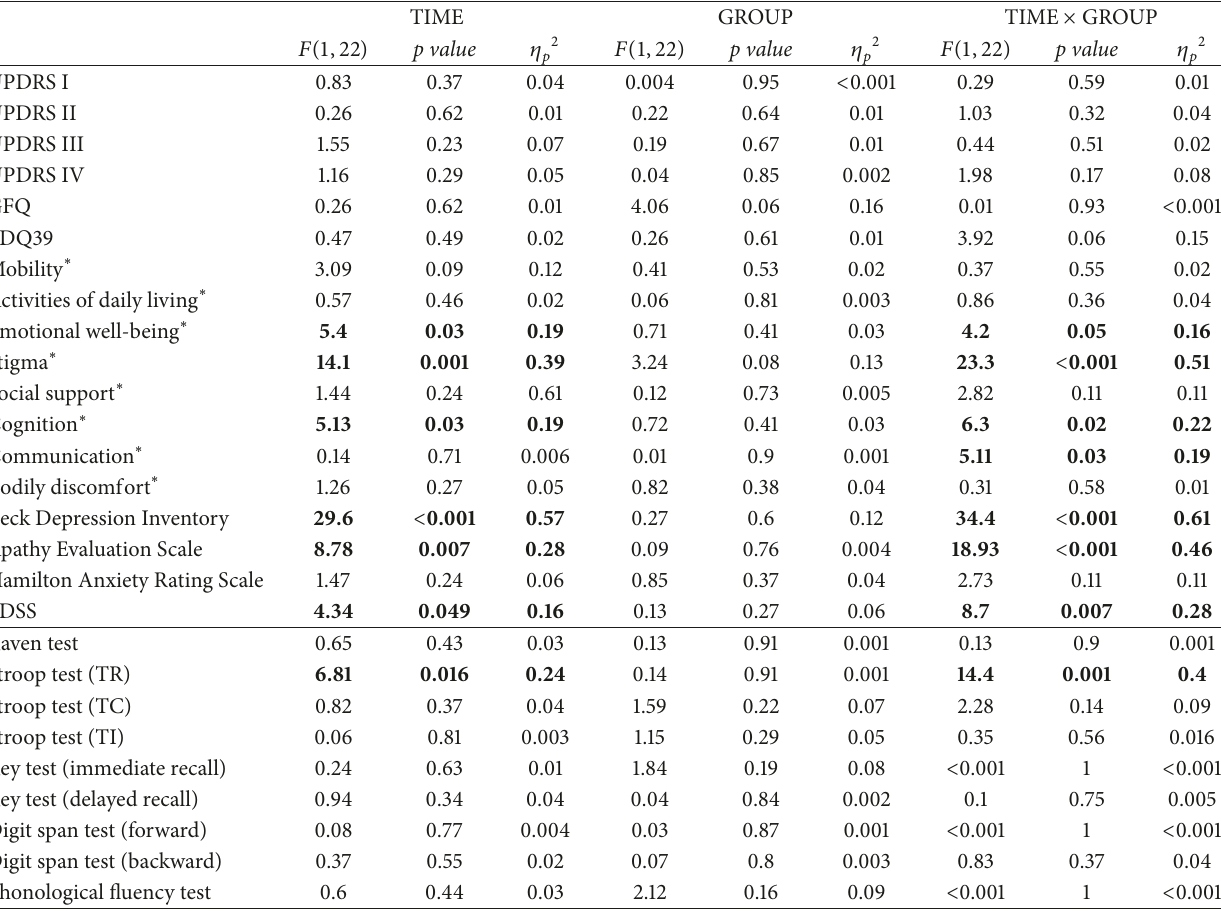
Table 6: Results of the two-way mixed-design ANOVA with GROUP (theatre; controls) as between subjects’ factor and TIME ( 𝑇0, 𝑇1 ) as within subjects’ factor, comparing scores of clinical scales (or subscales, top part of the table) and of neuropsychological tests (lower part of the table). Asterisk ( ∗ ) indicates subscales of Parkinson’s Disease Quality of Life Scale (PDQ39). 𝜂 𝑝2 represents the partial eta-squared; values higher than 0.14 indicate strong effect sizes (see Section 2.5 for further details). 𝑝 values less than 0.05 as well as the corresponding 𝐹 and 𝜂 𝑝2 values are indicated in bold. Unified UPDRS: Parkinson’s Disease Rating Scale; GFQ: Gait and Falls Questionnaire; PDSS: Parkinson’s Disease